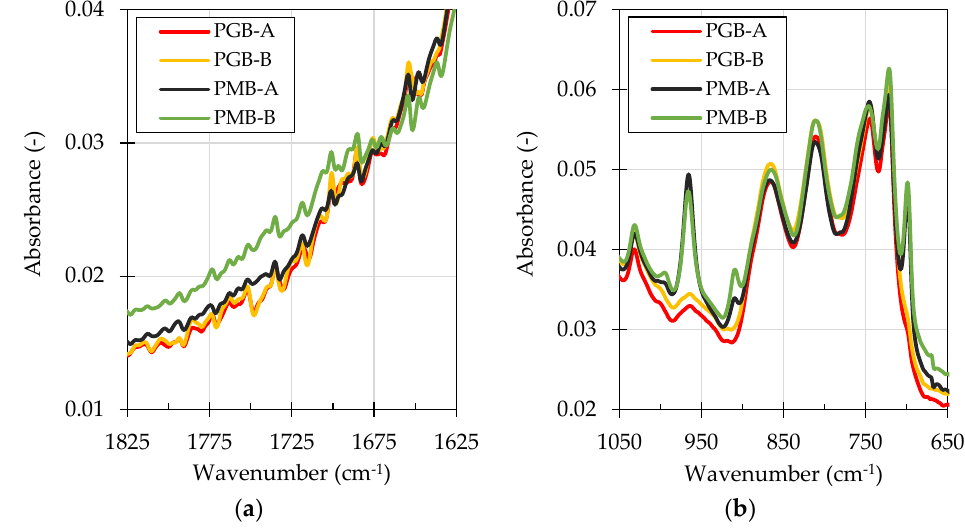
Figure 8. Infrared (ATR-FTIR) absorbance spectra of the evaluated binders in the 1625 – 1825 cm − 1 ( a ) and the 650 – 1050 cm − 1 ( b ) wavenumber ranges.